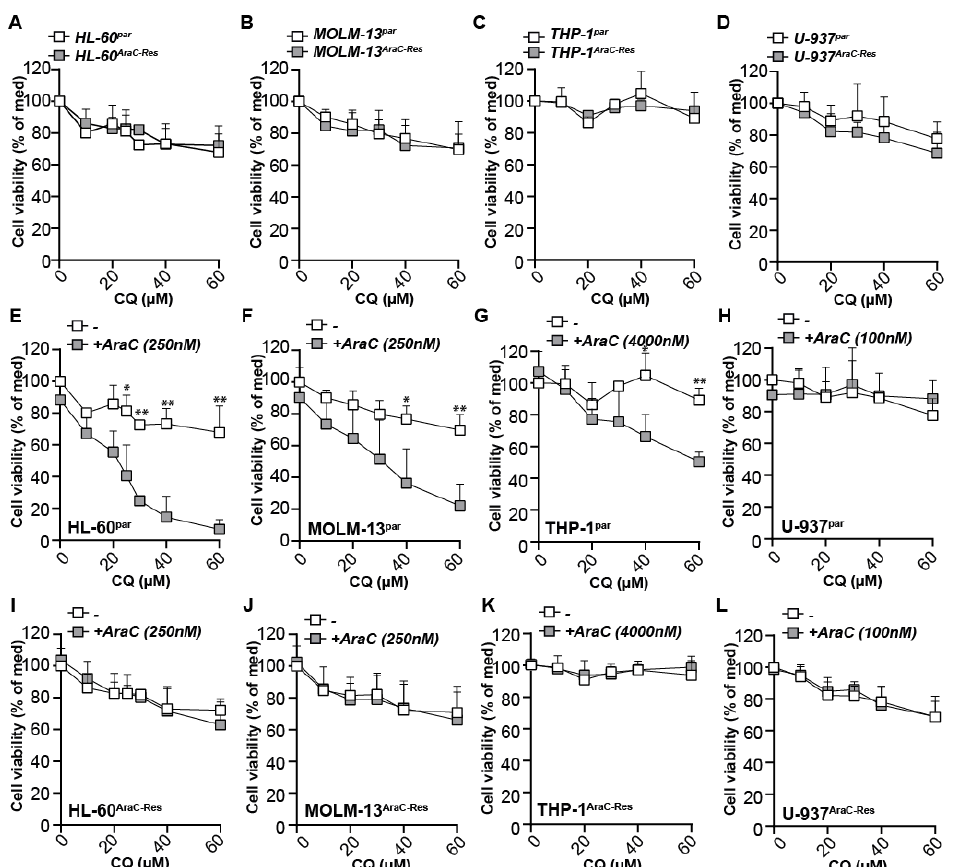
Figure 4. The autophagy inhibitor chloroquine (CQ) increases the efficacy of AraC in parental cells, but does not re-sensitize AraC-resistant cells for AraC. ( A – D ) Cell viability (MTS assays) of HL-60, MOLM-13, THP-1, and U-937 cell line pairs upon treatment with a concentration range of CQ (72 h, n = 3). ( E – H ) Parental HL-60, MOLM-13, THP-1, and U-937 cells were treated for 72 h with various concentrations of CQ in combination with a sublethal dose of AraC. Cell viability was measured using MTS assays after 72 h of incubation (at least n = 3) ( I – L ) As in ( E – H ) but using the AraC-Res cell lines. Of note, CQ was pre-incubated for 1 h before adding AraC. Significance was tested using student’s t -test. p values are indicated as: ** p < 0.01, and * p < 0.05.